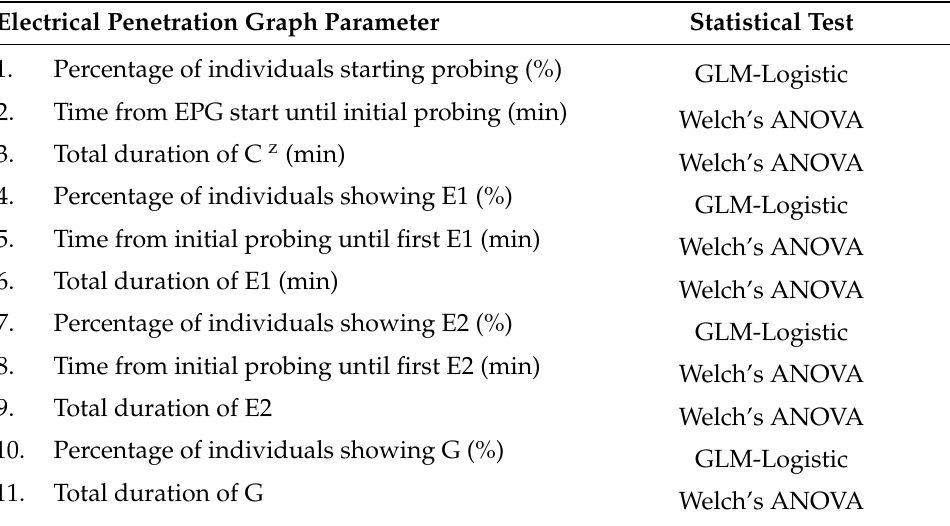
Table 1. Electrical penetration graph parameters about feeding behavior of Acanthococcus lager- stroemiae on different plant species and statistical tests